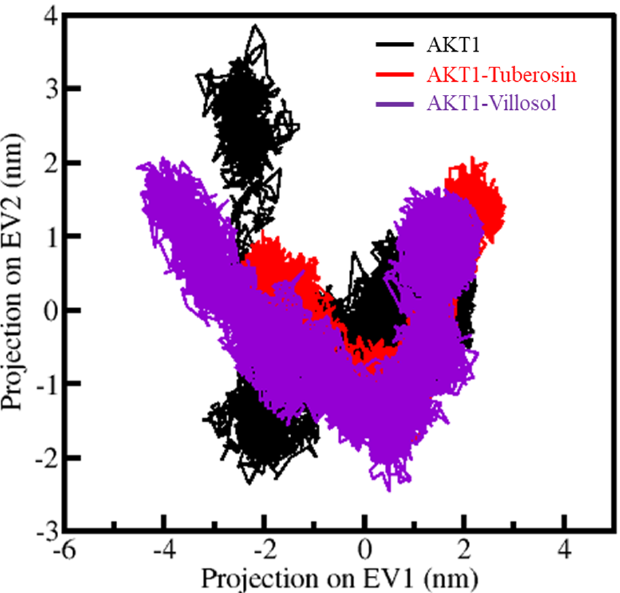
Figure 7. The conformational sampling in principal compound analysis (PCA). The two-dimensional projections illustrate the conformational sampling of AKT1-tuberosin and AKT1-villosol complexes.